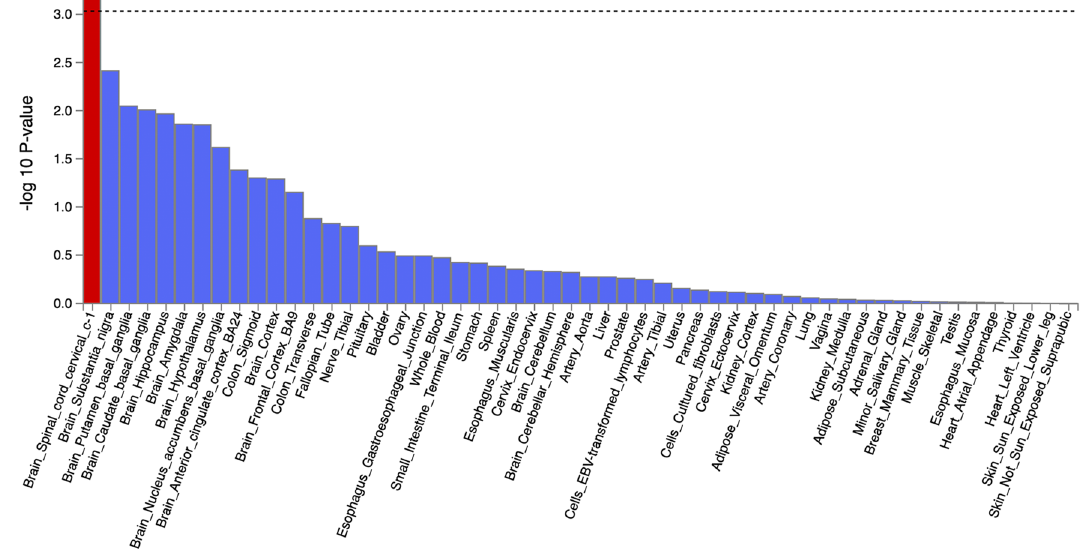
Figure 4. MAGMA tissue expression analysis of 54 tissue types from the genotype-tissue expression (GTEx) database. The bar plot was generated using FUMA v1.3.6 (https ://fuma.ctgla